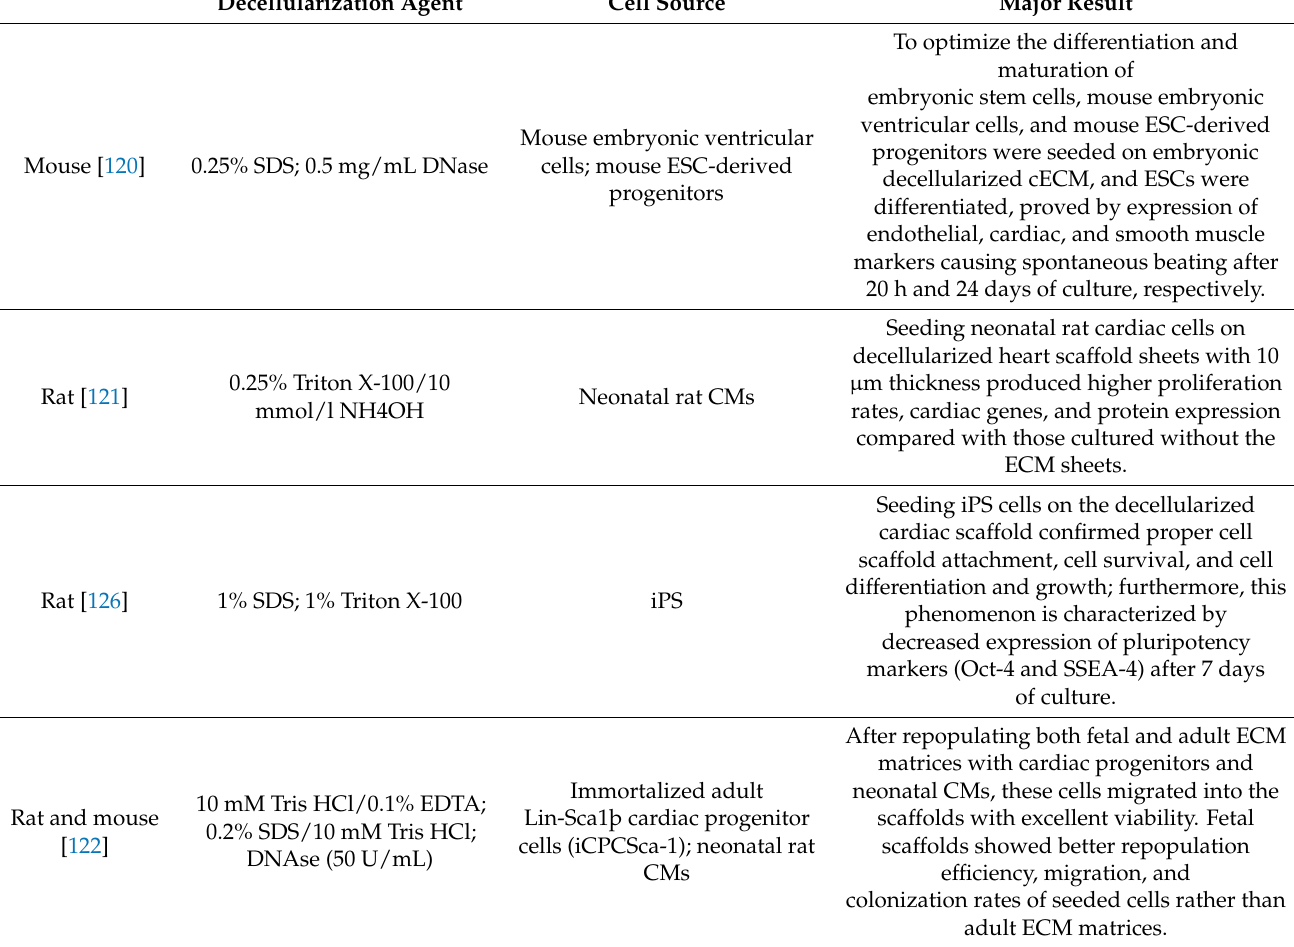
Table 4. Rodent natural myocardial ECM used for cardiac